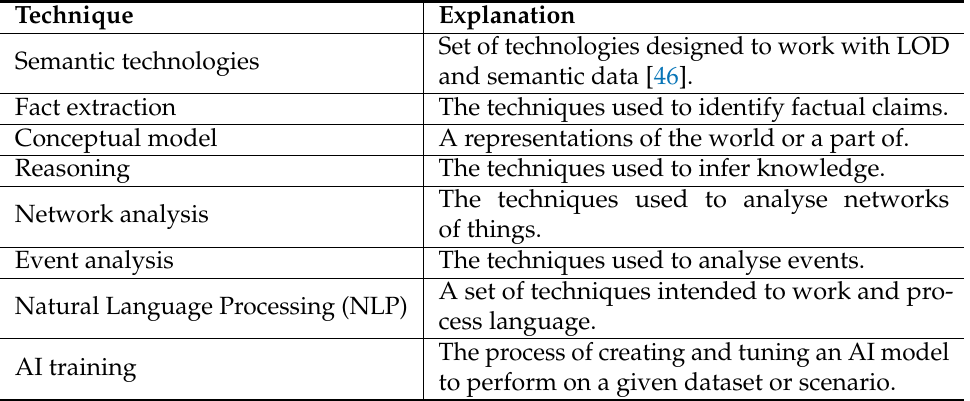
Table 4. The most common IT techniques used in